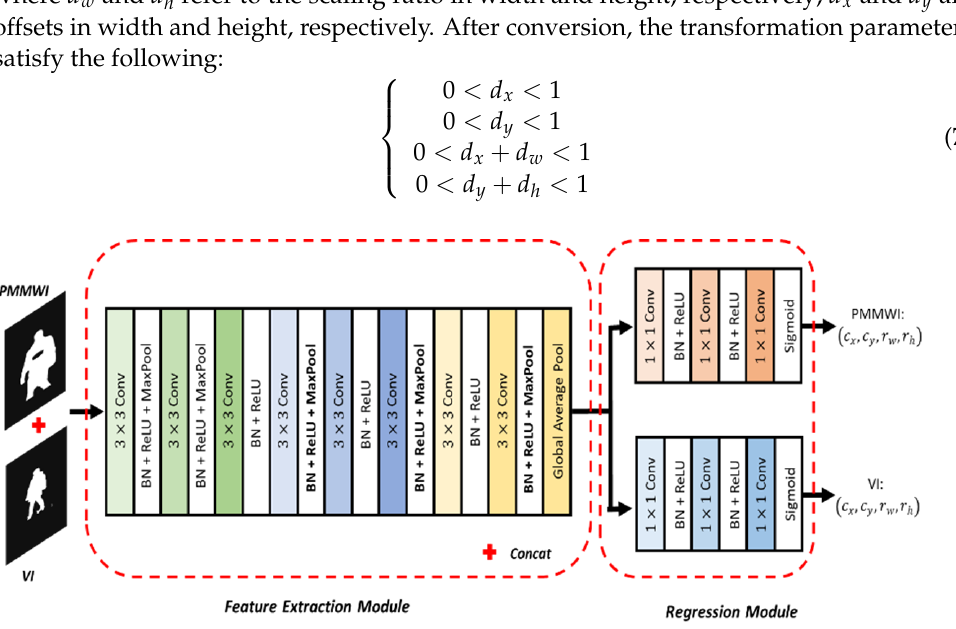
Figure 5. Framework of the proposed registration network.